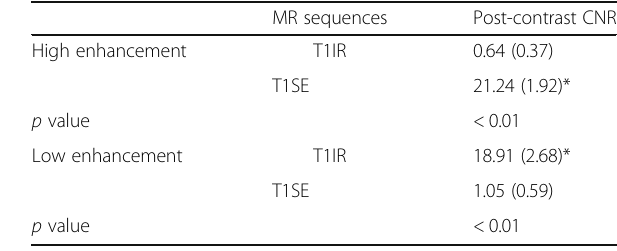
Table 2 Difference between T1IR and T1SE in CNR based on type of lesion MR sequences Pre-contrast CNR Post-contrast CNR Extra-axial lesion Table 3 Difference between T1IR and T1SE in CNR based on enhancement